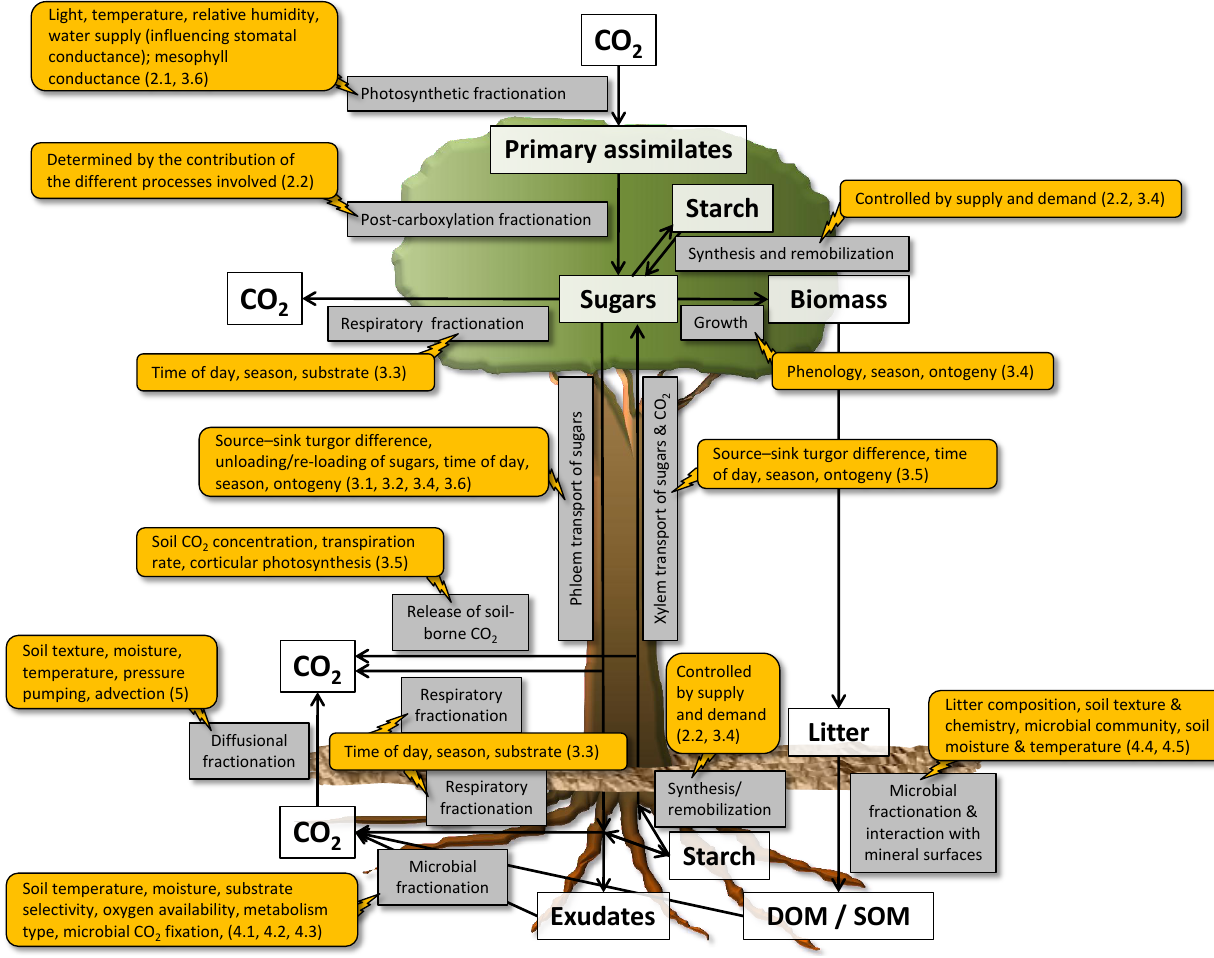
Fig. 4. Overview of processes and factors determining the isotope signature of C pools and fluxes in space and time in the plant-soil- atmosphere continuum. White boxes represent pools, gray boxes show fractionation or other processes determining the C isotope composition of the involved compounds, and orange boxes depict control factors. The numbers in parentheses refer to the respective chapters of the review.